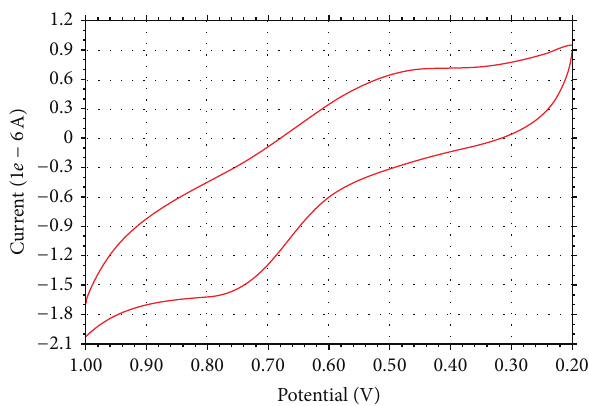
Figure 4: Cyclic voltammogram of Cu(II) complex at a scan rate of